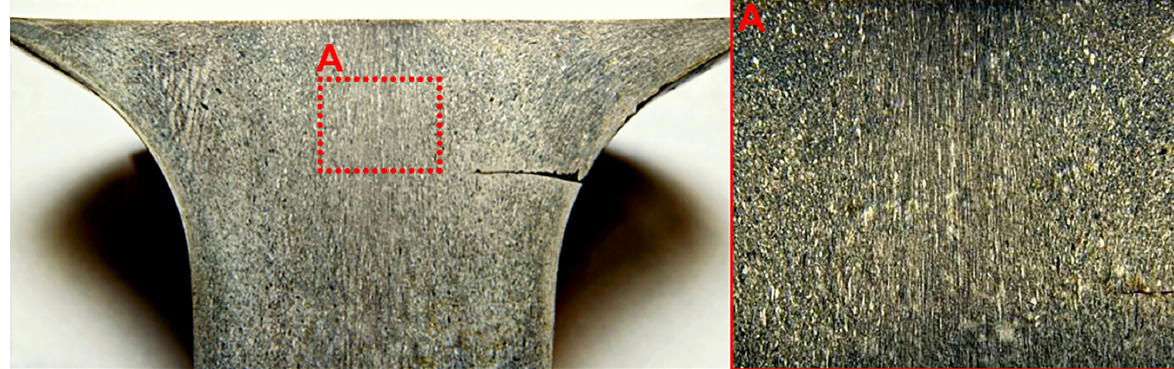
Figure 6. Macrostructure image of the initial section of the extruded